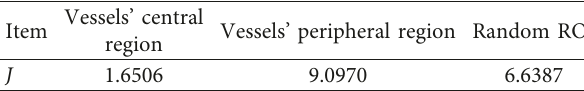
Figure 7: Spectral preprocessing procedure: (a) original spectral curve; (b) smoothed spectral curve; (c) spectral curve with SNV processing. Table 2: J values for different regions of the vessels.